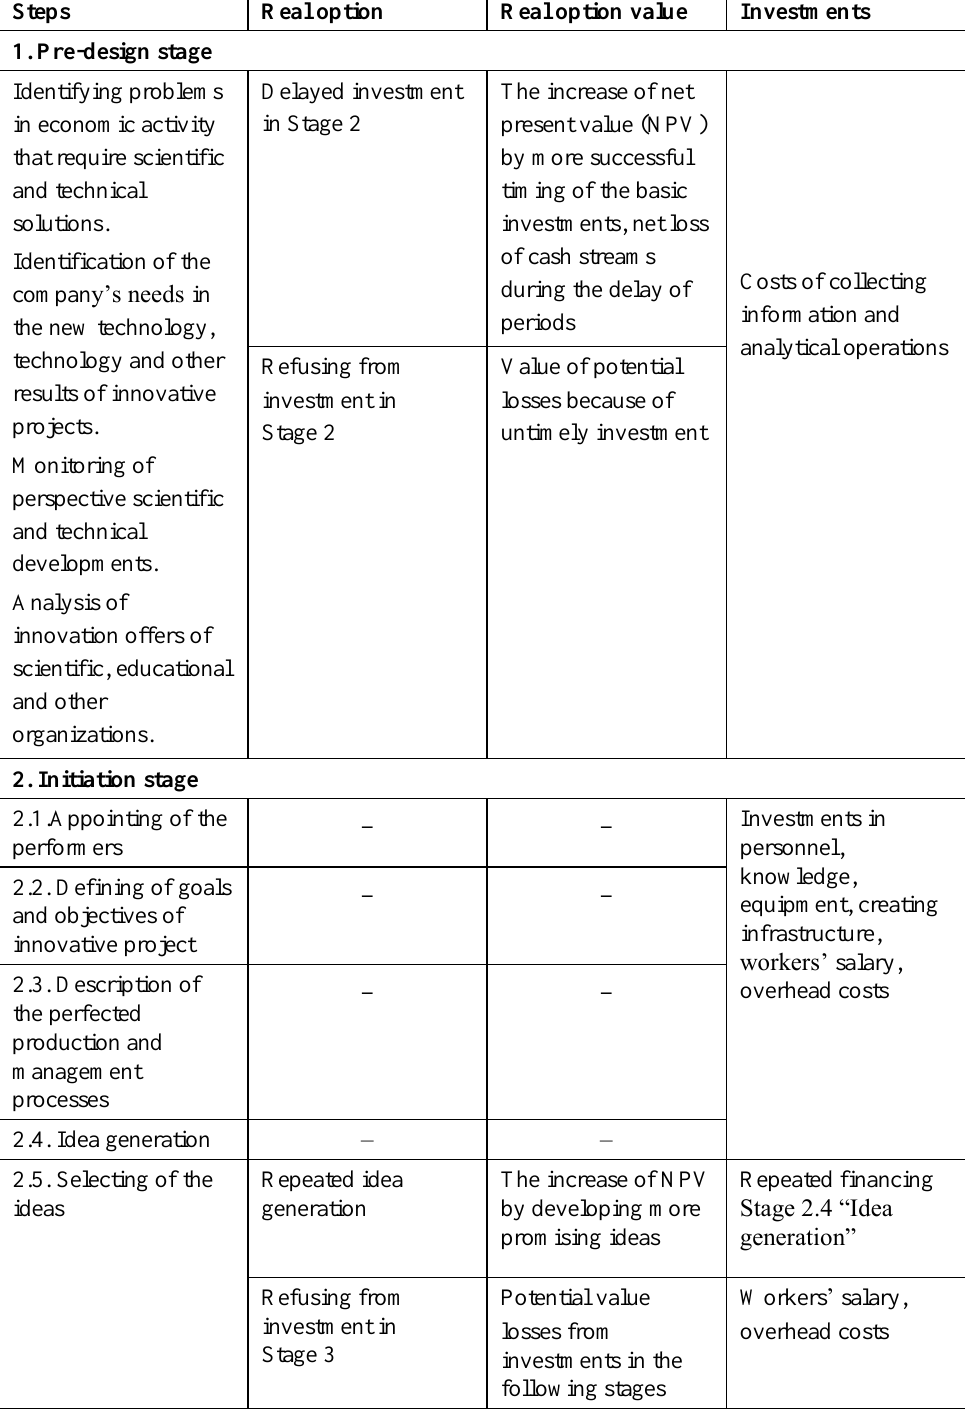
Table 2. Real Option in Innovative Project in